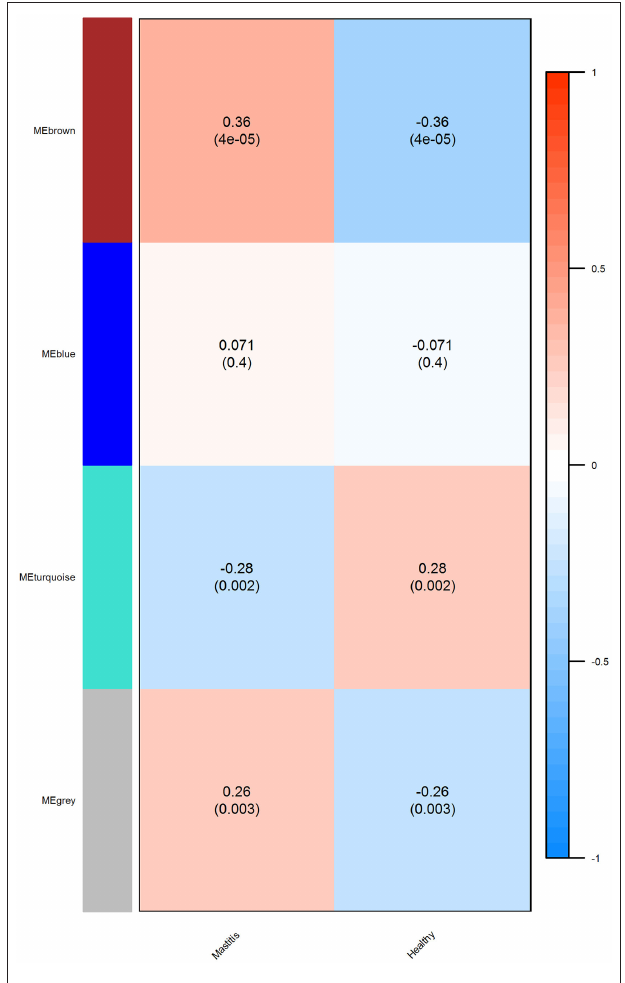
FIGURE 7 | The module trait relationship ( p value) for identified modules (y axis) in relation with traits (x axis). The relationship was colored according to the correlation between the module and traits (turquoise, strong negative correlation; brown, strong positive correlation).